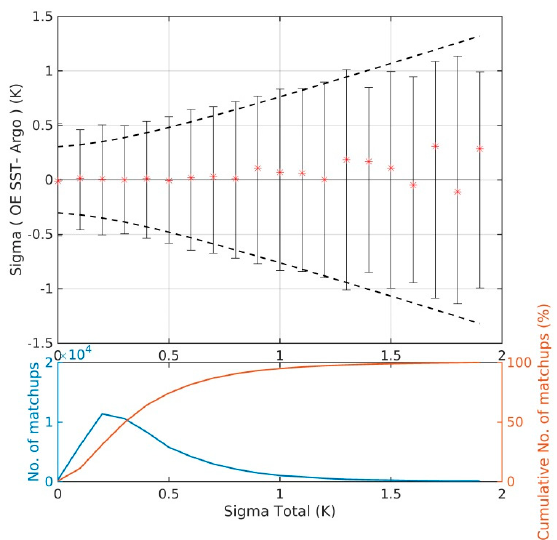
Figure 12. OE SST uncertainty validation with respect to Argo SSTs. Dashed lines show the ideal